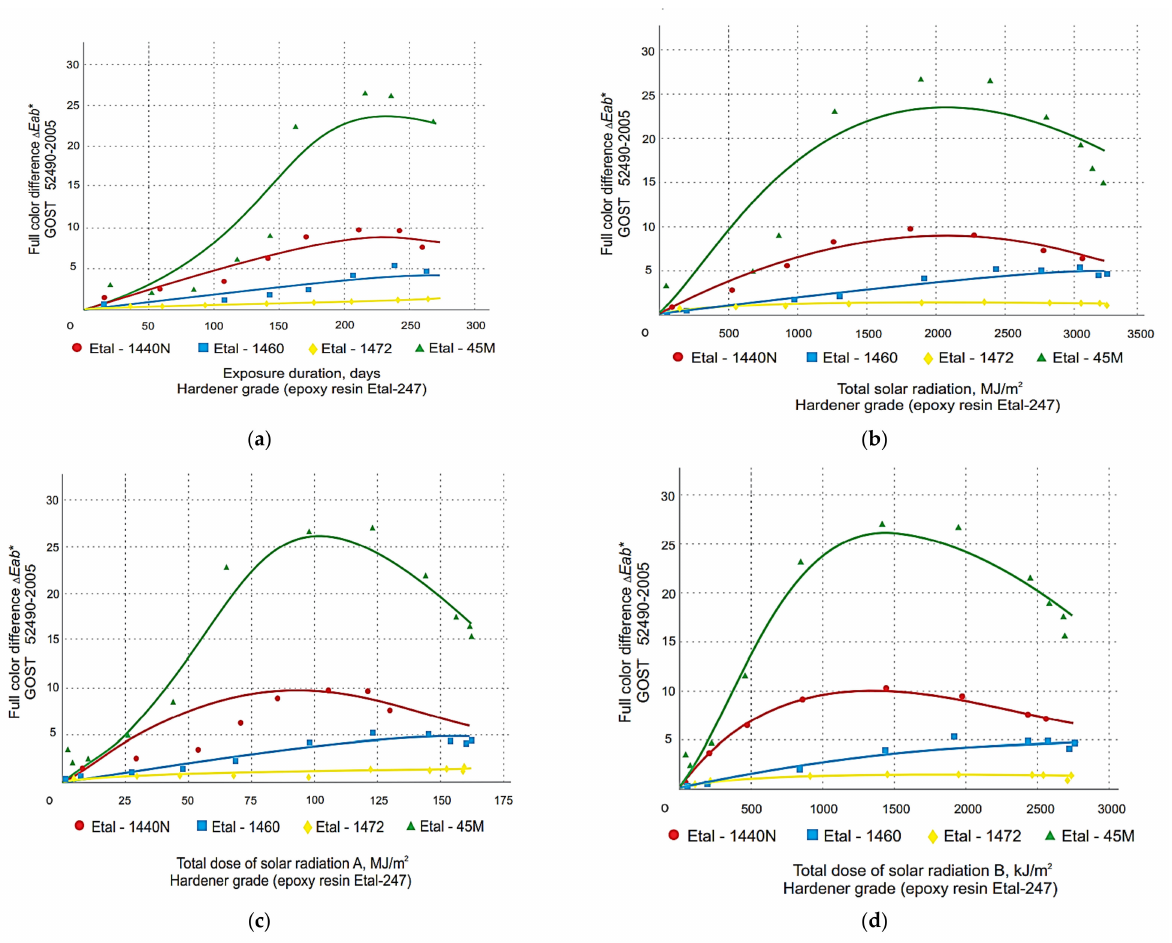
Figure 2. Change in the total color difference of polymers based on the modified Etal-247 epoxy resin depending on the exposure time ( a ), total solar radiation ( b ), total ultraviolet radiation of the range A ( c ) and B ( d ) when exposed under the influence of climatic factors.